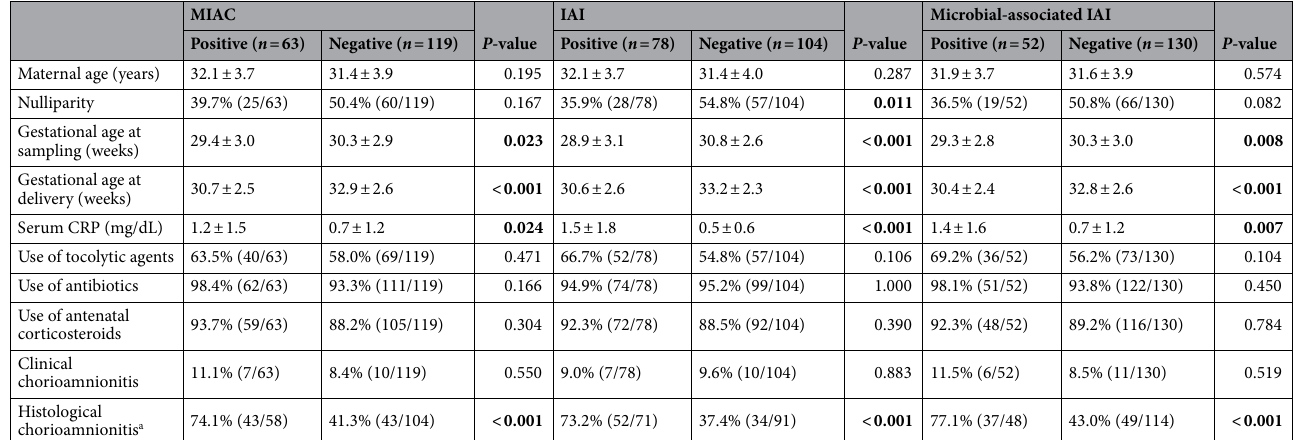
Table 2. Demographic and clinical characteristics of the study population according to the presence or absence of microbial invasion of the amniotic cavity (MIAC), intra-amniotic inflammation (IAI), and microbial-associated IAI in women with preterm premature rupture of membranes. CRP, C-reactive protein. Data are given as mean ± standard deviation or % (n/N). a Data for the histologic evaluation of the placenta were only available in 162 of the 182 women because in 17 cases, delivery took place at another institution and in 3 cases, histologic evaluation of the placenta was not performed because of our institutional policy that only the placentas in cases of preterm delivery are to be sent for histopathologic examination or because of missing data for the histological chorioamnionitis. Significant values are in [bold].